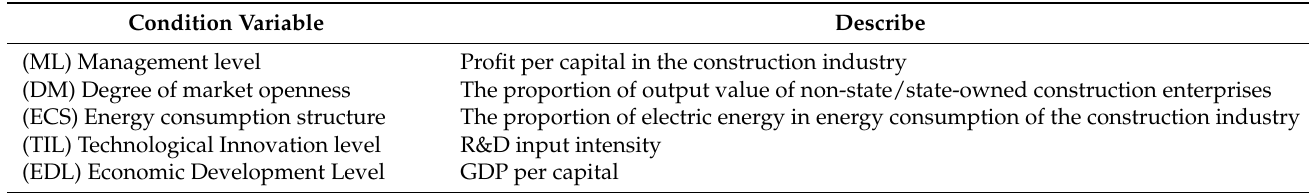
Table 2. Model variables and their descriptions.